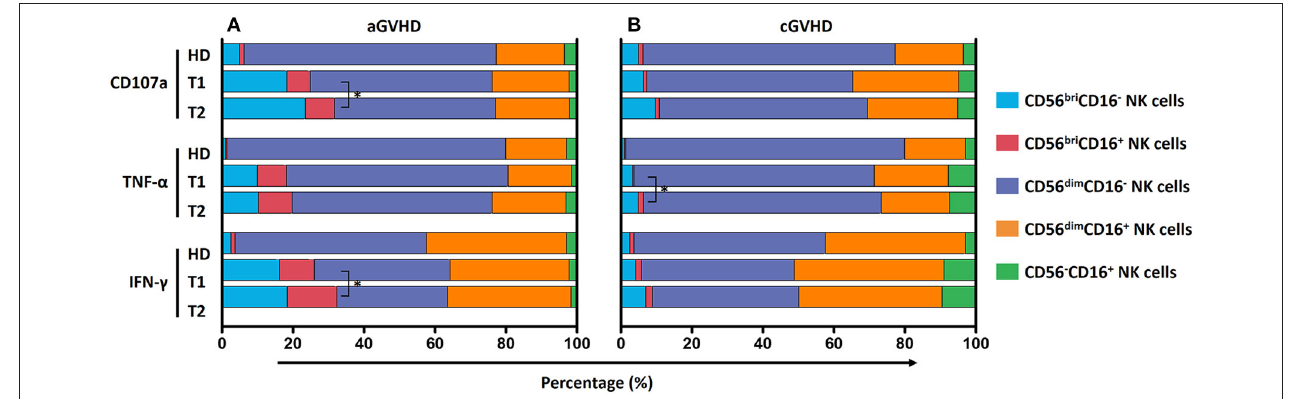
FIGURE 9 | Effect of ECP on the contribution of NK subsets to GVL effect. The contribution of five different NK subpopulations with the respect to CD107a expression, TNF- α and IFN- γ secretion was investigated in both aGVHD ( n = 14, excluding patient #5 and #8 due to the limited cell number of samples) (A) and cGVHD patients ( n = 13, excluding patient #17, #18, #21, #22, and #25 due to the limited cell number of samples) (B) . ECP therapy could improve CD107a expression and IFN- γ secretion by CD56 bri CD16 + / − NK cells in aGVHD patients (A) , while improve TNF- α secretion by CD56 bri CD16 + / − NK cells in cGVHD patients (B) . * p <